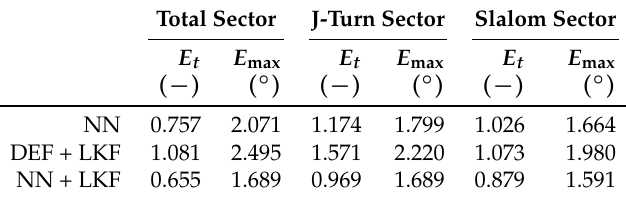
Table 6. Norm and maximum errors for roll angle estimators for J-turn and slalom maneuvers.